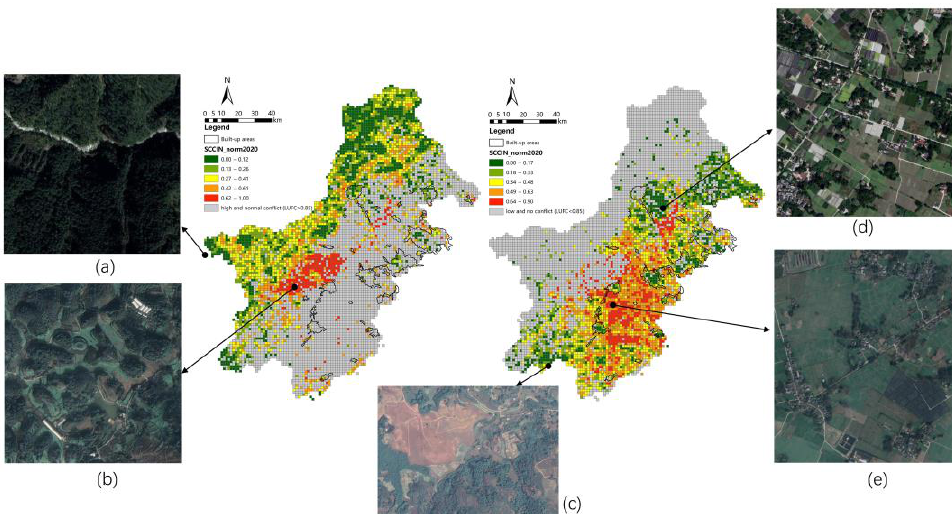
Figure 9. Types of landscape complexity conflicts for units of high or low functional suitability conflict, with typical sites of ( a ) low LUFC and low landscape complexity conflicts, ( b ) low LUFC and high landscape complexity conflicts, ( c ) high LUFC and low landscape complexity conflicts with ecological aspects dominating, ( d ) high LUFC and high landscape complexity conflicts, ( e ) high LUFC and low landscape complexity conflicts with production aspects dominating.